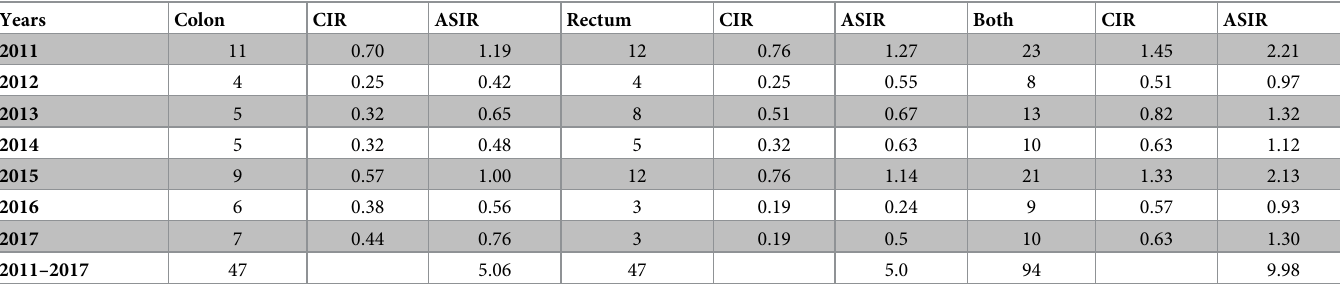
Table 3. Annualised crude incidence rate per 100,000.